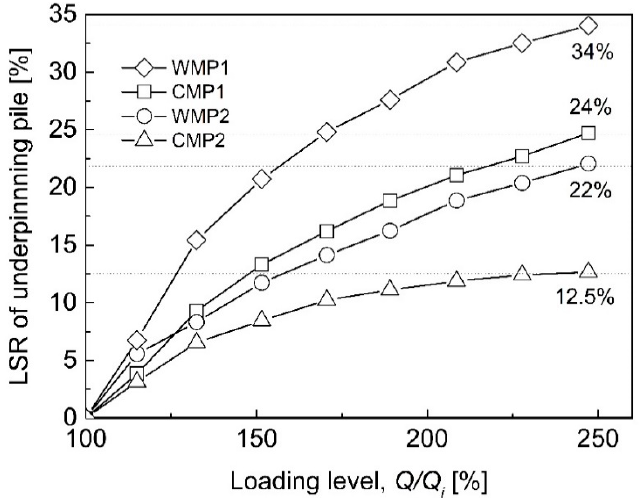
Figure 11. Load sharing ratio (LSR) of underpinning pile with respect to additional loading level.